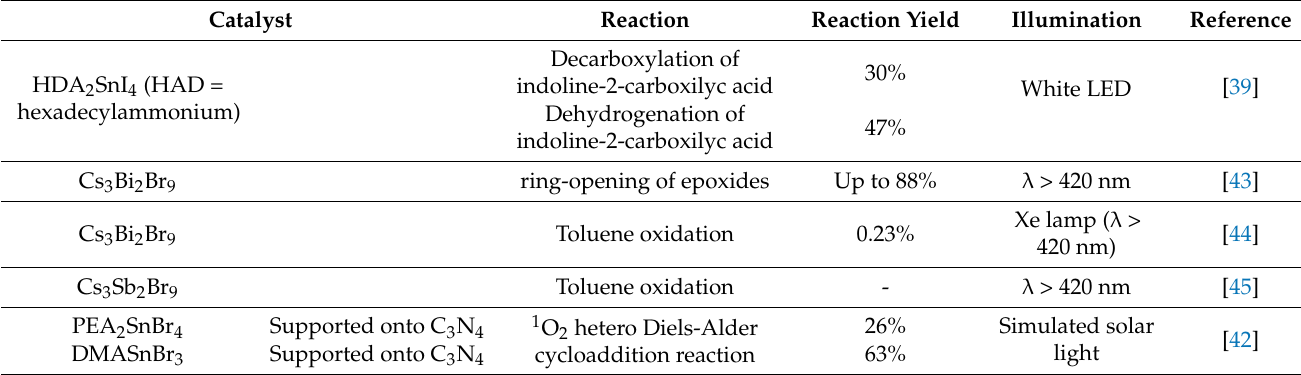
Table 3. Pb-free photocatalytic systems reviewed in the present paper highlighting the reaction, reaction yield, and illumination mean. Catalyst Reaction